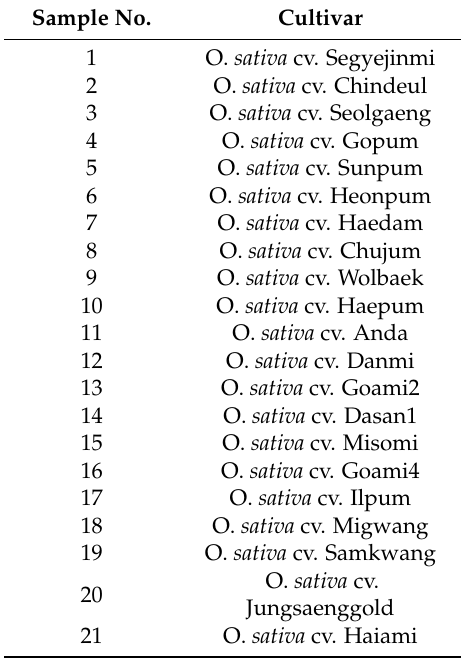
Table 1. The characteristic of rice bran by cultivars. Sample